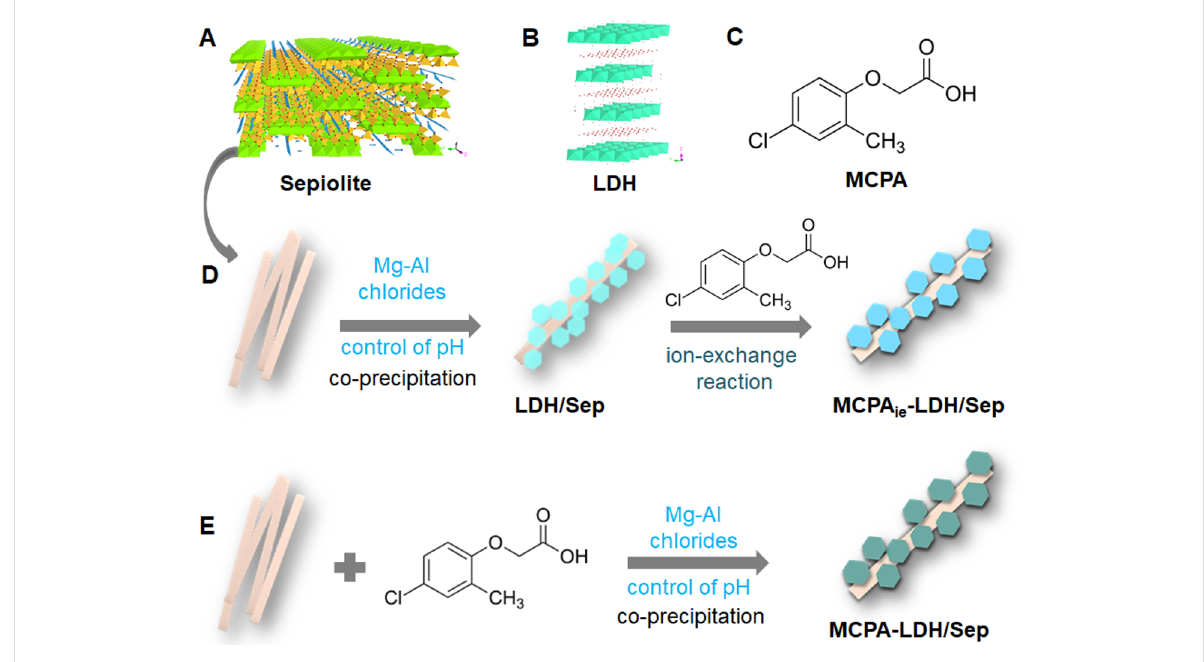
Figure 1: Schematic representations of (A) sepiolite and (B) layered double hydroxide structures, (C) molecular structure of 2-methyl-4-chlorophe- noxyacetic acid (MCPA), and schemes of the synthesis of the hybrid MCPA-LDH/sepiolite nanoarchitectures by (D) ion exchange and (E) one-step